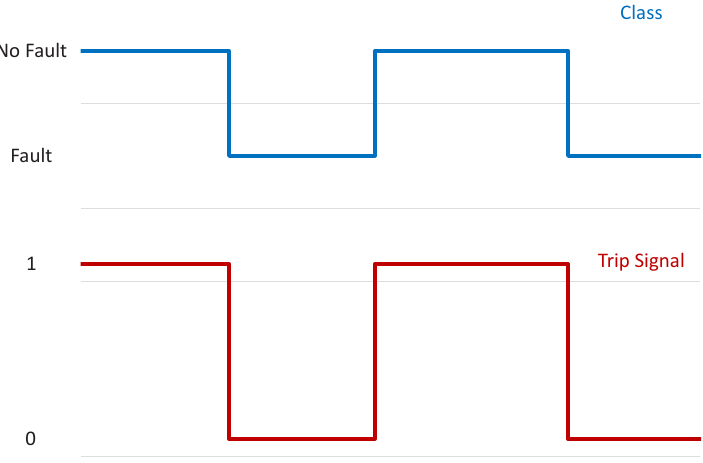
Figure 23. Fault as a NF detection and respective trip signal.